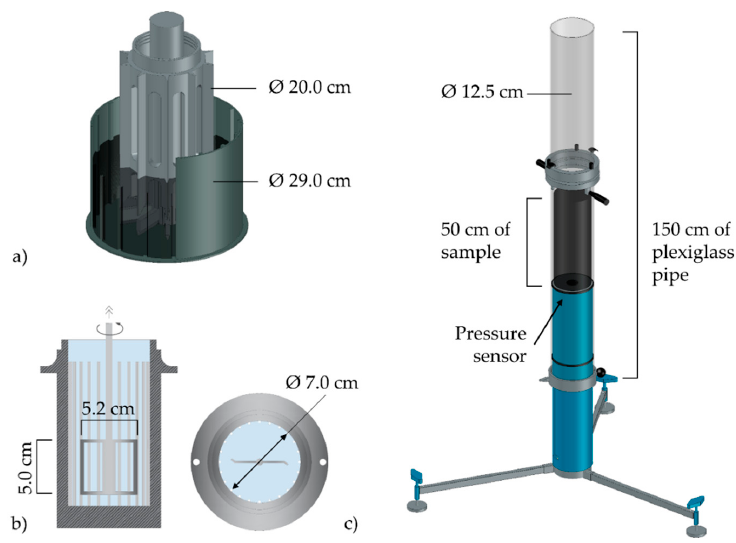
Figure 2. ( a ) ConTec 5 viscometer, ( b ) HAAKE MARS II rheometer, and ( c ) Sliding pipe rheometer (Sliper).